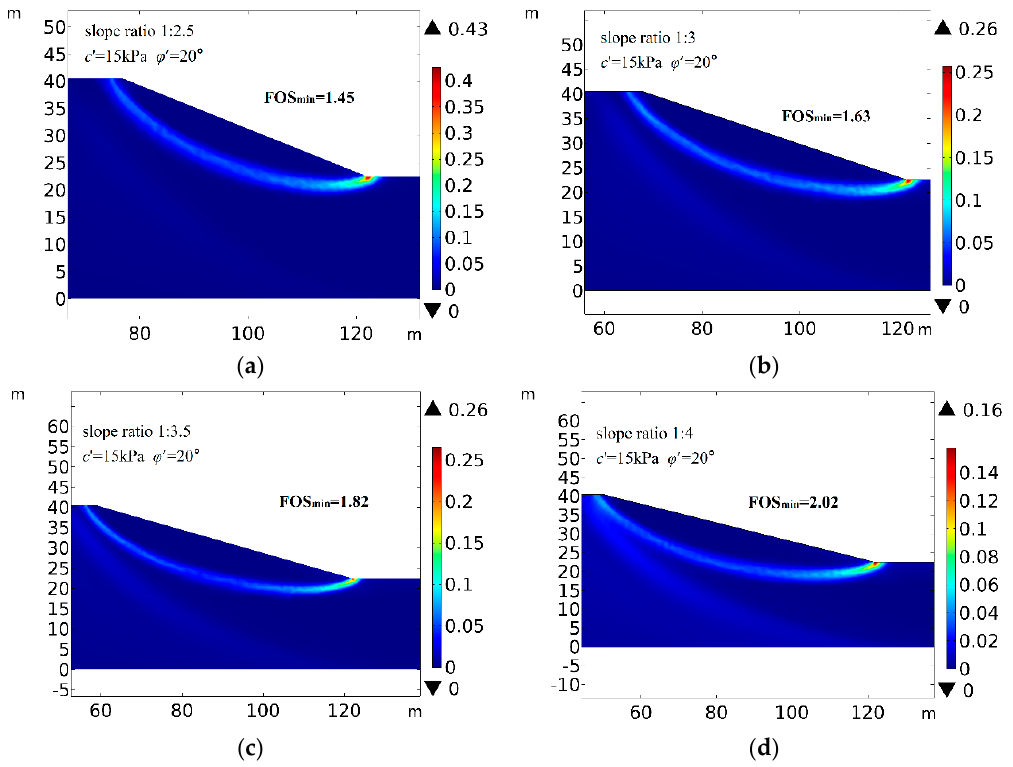
Figure 8. Plastic penetration zones in the slope with different slope ratios: ( a ) slope ratio 1:2.5, ( b ) slope ratio 1:3, ( c ) slope ratio 1:3.5, ( d ) slope ratio 1:4.